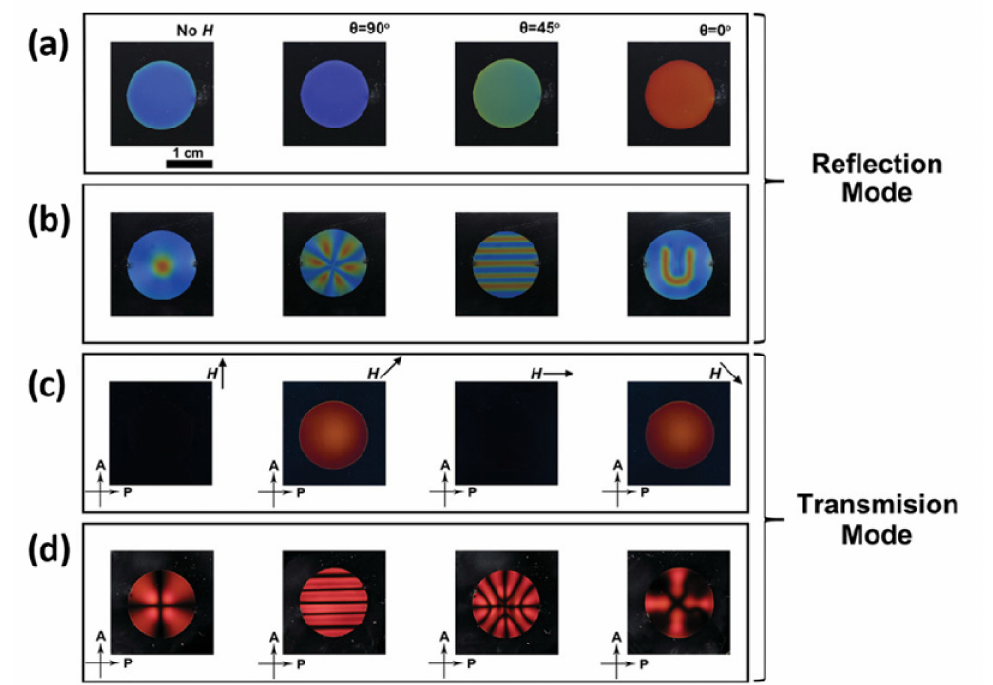
Figure 3. Magnetic-responsive PC patterns based on their photonic band-gap and birefringence properties for anti-counterfeiting. ( a ) Digital photos showing that the structural color of the anti-counterfeiting device based on magnetic-responsive PC strongly depends on the magnetic field and the direction of the magnetic field. ( b ) Digital photos of the anti-counterfeiting device showing di ff erent patterns under di ff erent non-uniform magnetic fields. ( c ) The transition between dark and bright states through changing the direction of the magnetic field in the horizontal plane. ( d ) The device showing di ff erent patterns when applying a di ff erent non-uniform magnetic field. Reused with permission from Reference [61], Copyright 2019,